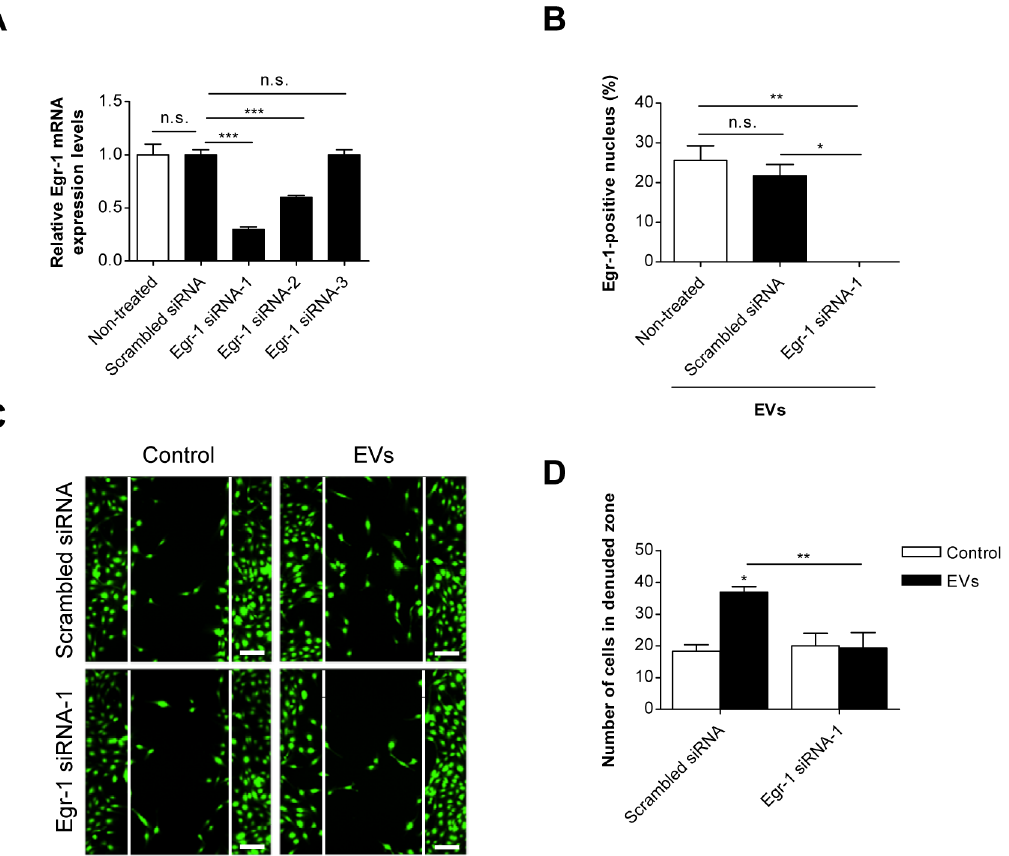
Fig. 3. Inhibition of Egr-1 activation and endothelial cell migration by Egr-1 siRNA. (A) HMEC-1s were transfected with 50 nM of scrambled siRNA or Egr-1 siRNA-1, Egr-1 siRNA-2, or Egr-1 siRNA-3. mRNAs were isolated from the cells after 48 h and the level of Egr-1 mRNA was analyzed using real time RT-PCR (n 5 3). (B) Nuclear translocation of Egr-1 protein after stimulation with SW480-derived EVs (1 m g/mL) for 1 h was analyzed in scrambled siRNA (50 nM) or Egr-1 siRNA-1 (50 nM) transfected HMEC-1s (n 5 3). (C, D) Confluent HMEC-1s transfected with scrambled siRNA (50 nM) or Egr-1 siRNA-1 (50 nM) were scratched and treated with SW480-derived EVs (1 m g/mL); then the number of migrated cells in the denuded zone was evaluated after 12 h (n 5 3). The number of migrated cells in the denuded zone of each group is shown in panel D. Scale bars represent 100 m m. Data are represented as mean ¡ SD. * P , 0.05; ** P , 0.01; *** P , 0.001; n.s., not